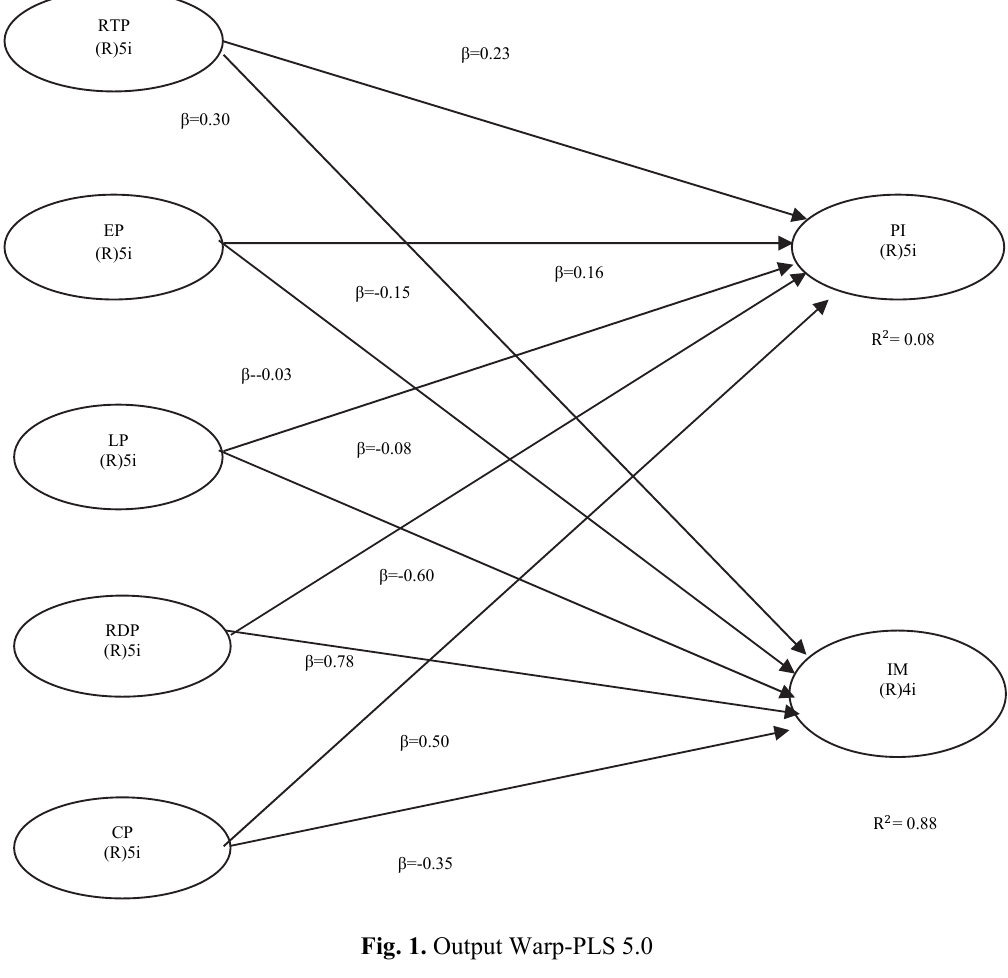
Fig. 1. Output Warp-PLS